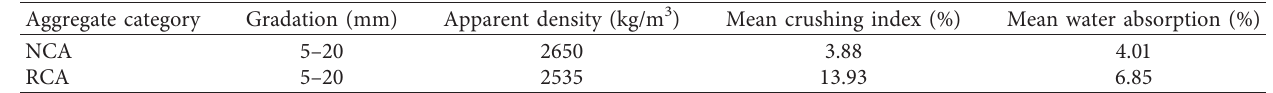
Figure 1: Schematic diagram of RCA. (a) RCA after treatment. (b) Shape of RCA used. Table 3: Aggregate properties.